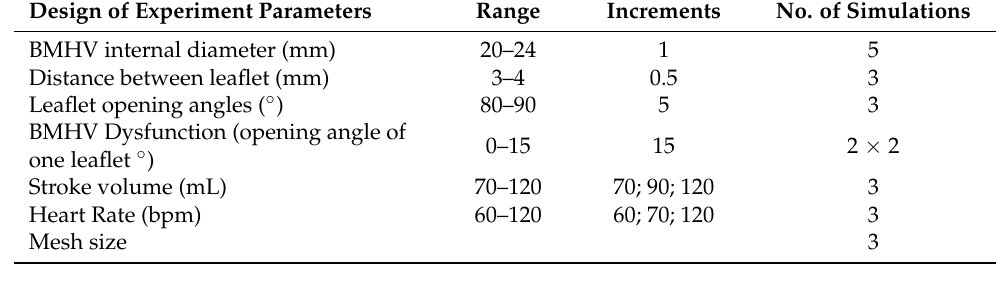
Table 2. Summary of the numerical simulation: Tested prosthesis and conditions with parameter values and increments—BMHV Dysfunction: Dysfunction with one leaflet blocked.